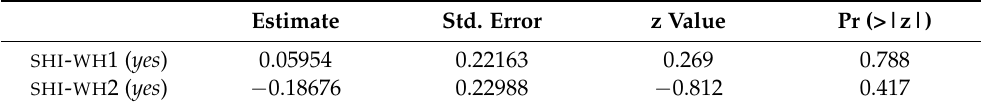
Table 5. Cumulative link mixed model fitted with the Laplace approximation. (Sub-experiment 2 | Nominal-specific.) Estimate